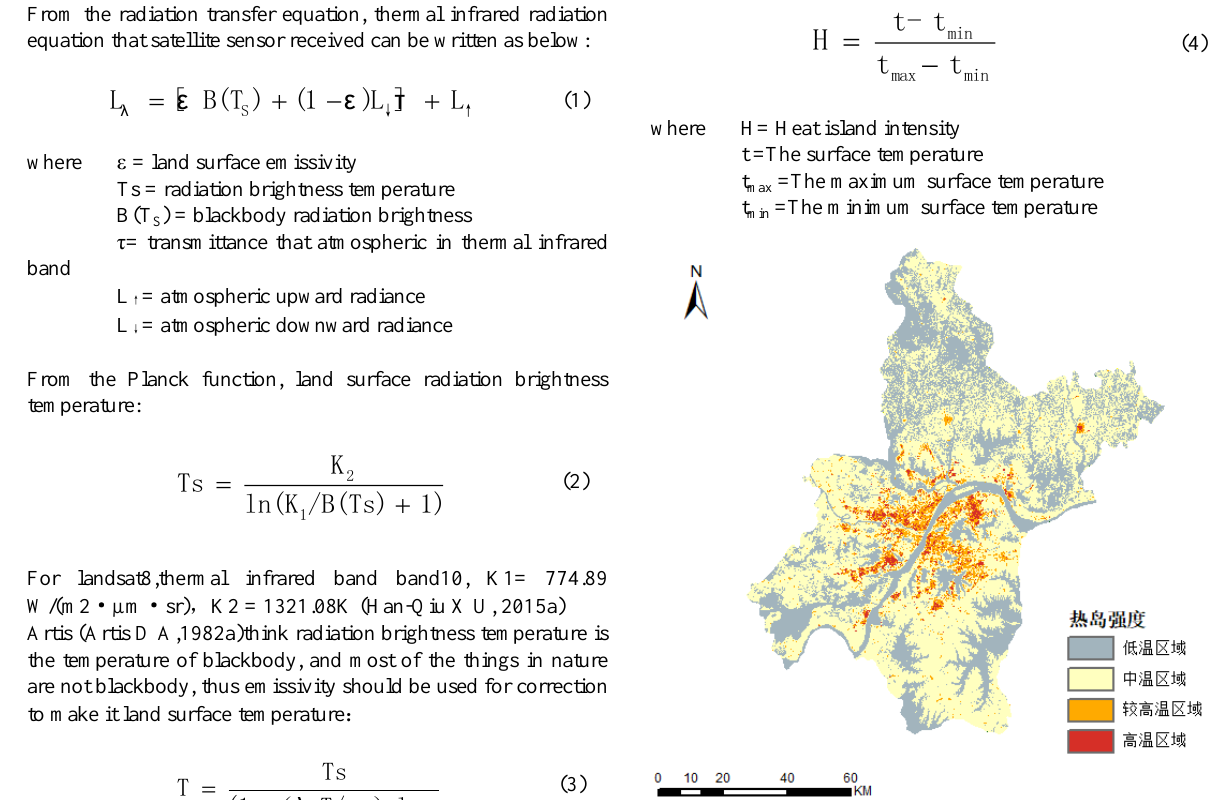
Figure 2.The map of heat island intensity 3.2 Vegetation coverage inversion Vegetation coverage is mainly characterized by fractional vegetation cover （ FVC ） which is an important index of land surface vegetation status. FVC of Wuhan was estimated using dimidiate pixel model based on the normalized difference vegetation index (NDVI) calculated by landsat8 spectral reflectance data.